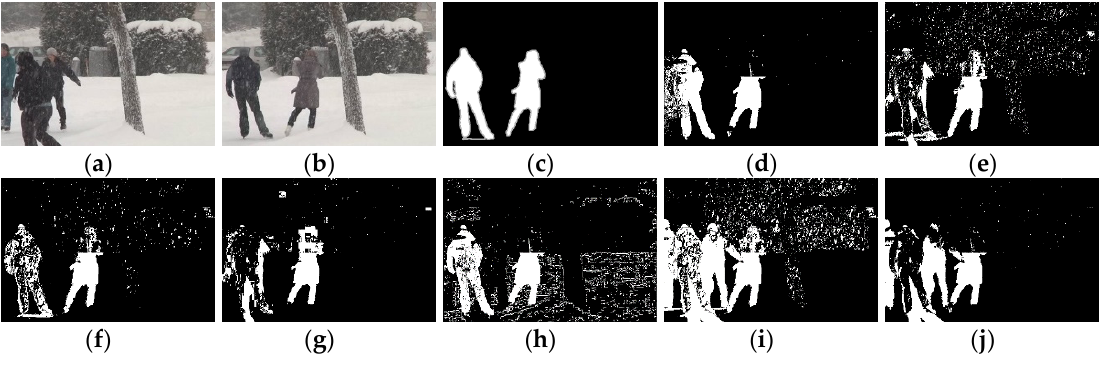
Figure 9. Comparison of segmentation results of seven background subtraction methods for one frame taken from the skating sequence. ( a ) Frame n (start image), ( b ) frame n + 99, ( c ) ground ‐ truth, ( d ) EBBE (proposed), ( e ) codebook, ( f ) GMM, ( g ) KDE, ( h ) PBBE, ( i ) SOBS, and ( j ) ViBe.